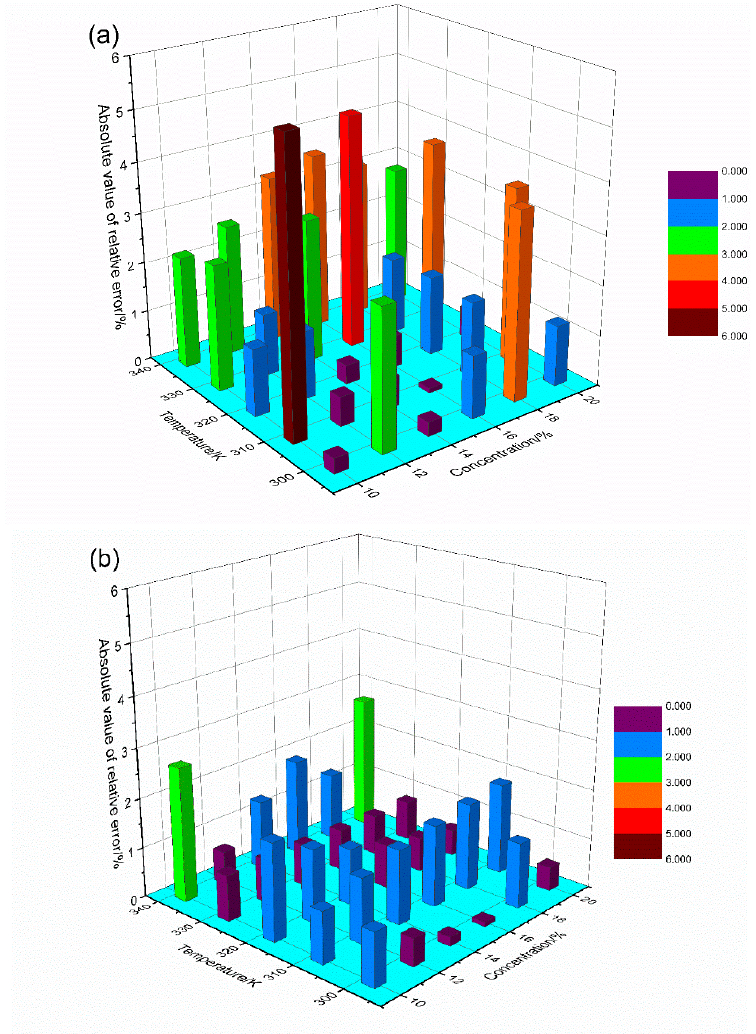
Figure 10. Absolute value of the relative error changes with concentration and temperature. ( a ) Before and ( b ) after compensation.